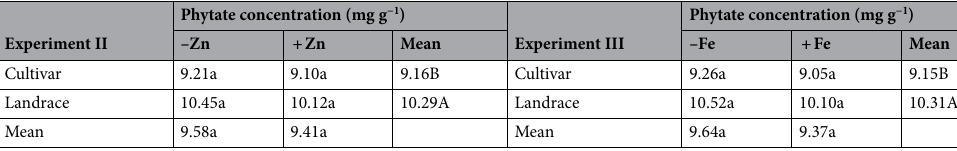
Table 2. Effects of foliar application of zinc (Experiment II) and iron (Experiment III) on the grain phytate concentration of Chinese wheat landraces and cultivars. Within the same row, values with different lowercase letter are significantly different at P = 0.05. Within the same column, means with different uppercase letter are significantly different at P = 0.05.